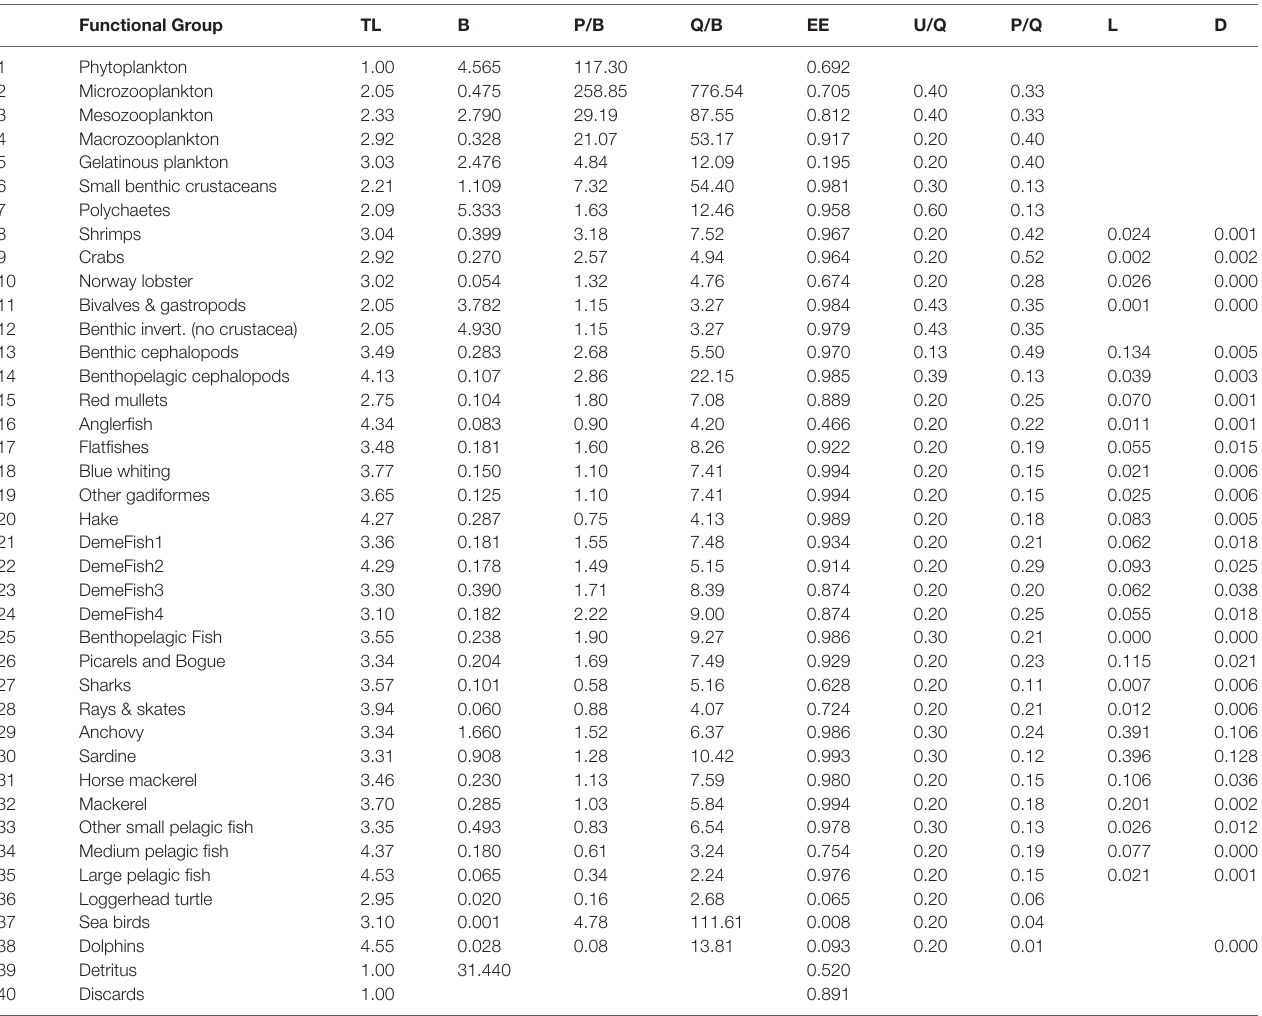
TABLE 1 | Functional groups and basic parameters of the Ecopath model. Functional